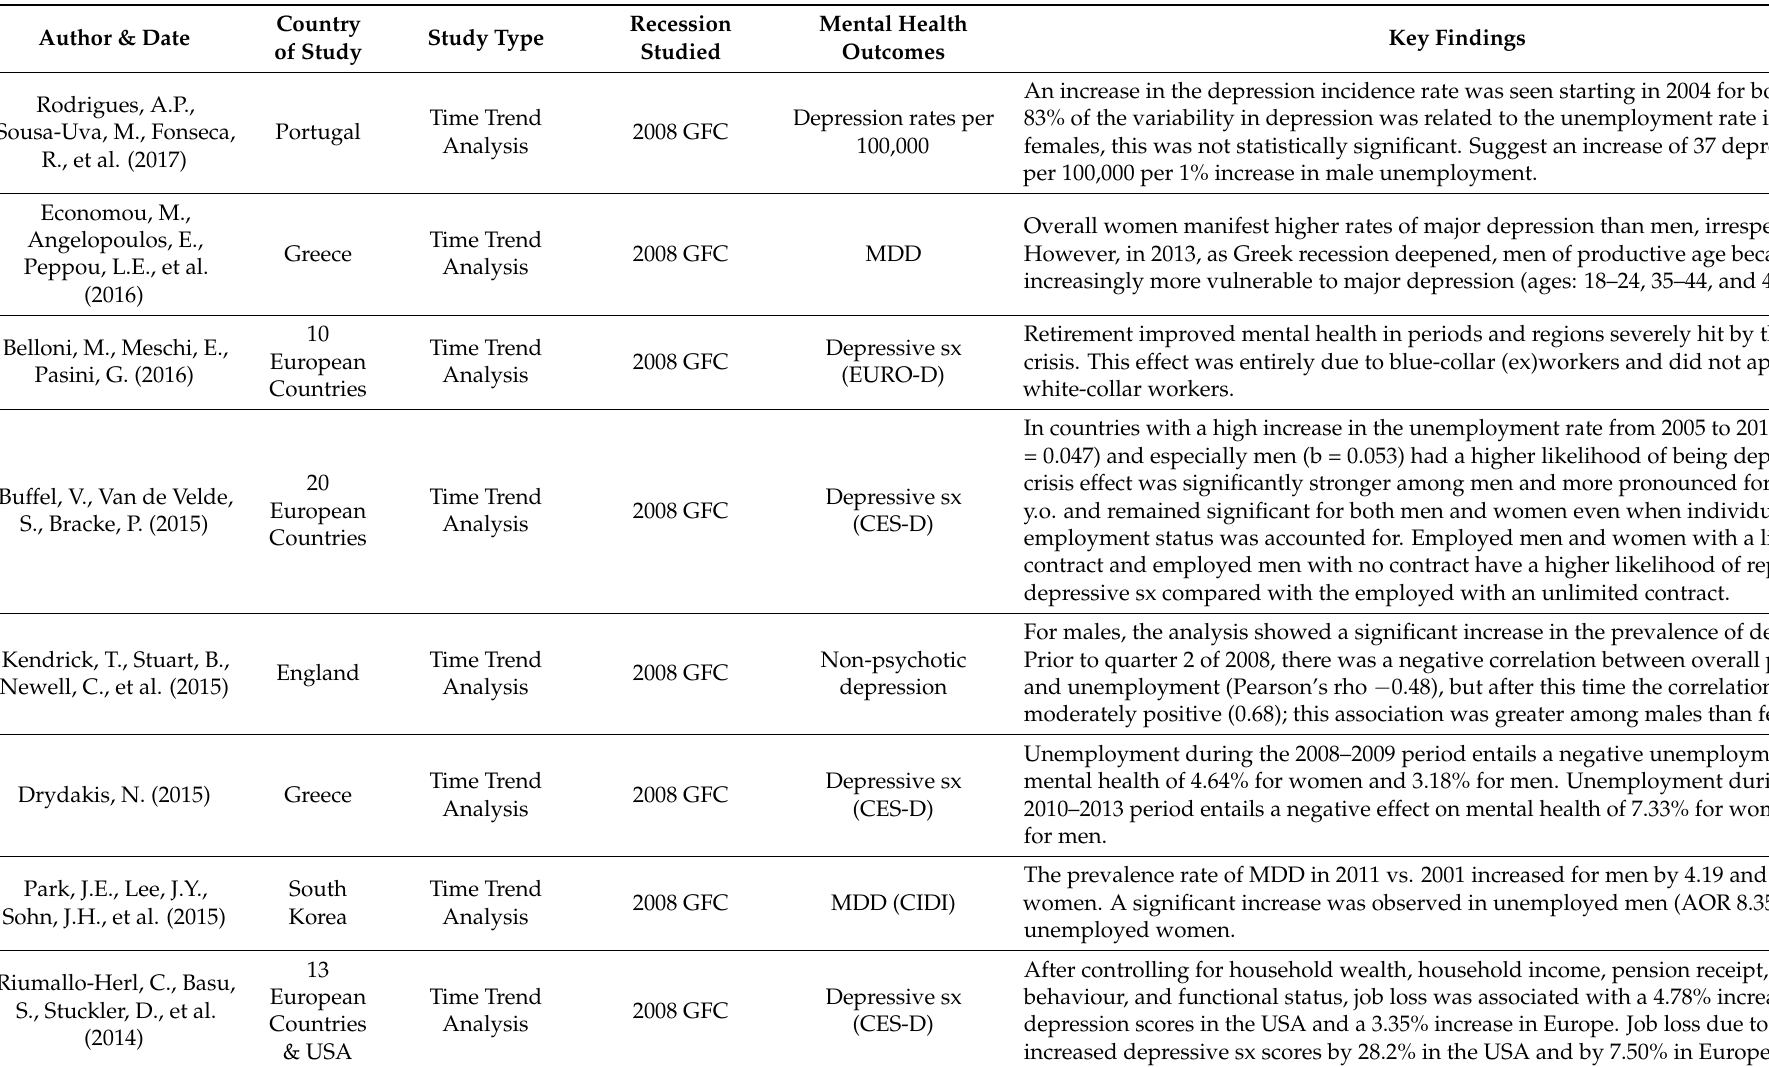
100,000 per 100,000 per 1% increase in male